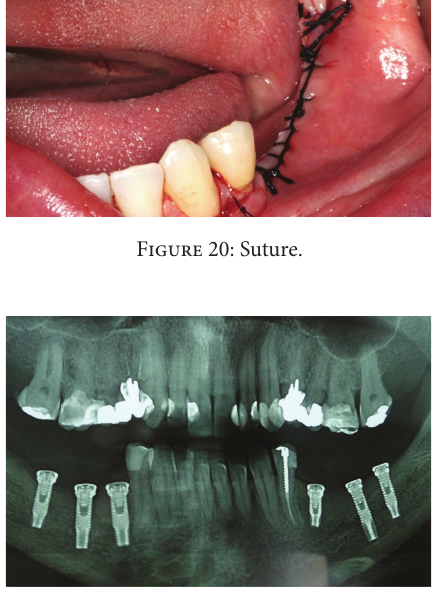
Figure 21: Panoramic